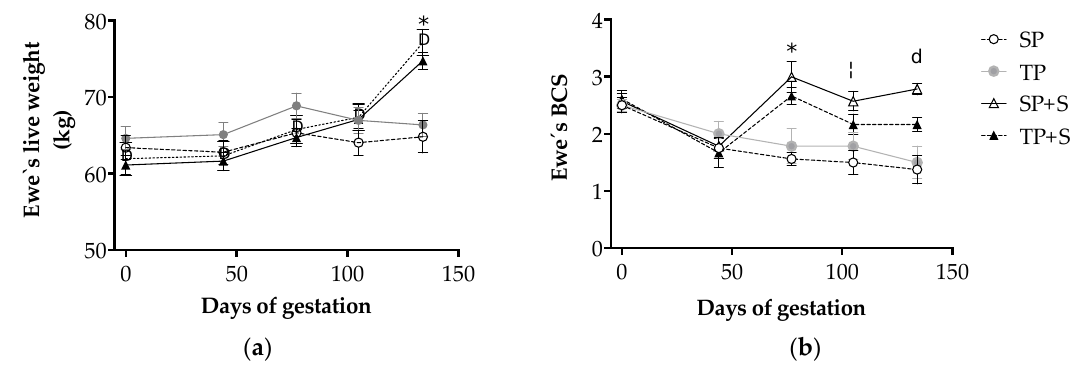
Figure 1. Live weight ( a ) and body condition score (BCS) ( b ) during fetal growth restriction pregnancy in ewes bearing single and twin fetuses, maintained under adequate or deprived nutritional planes.